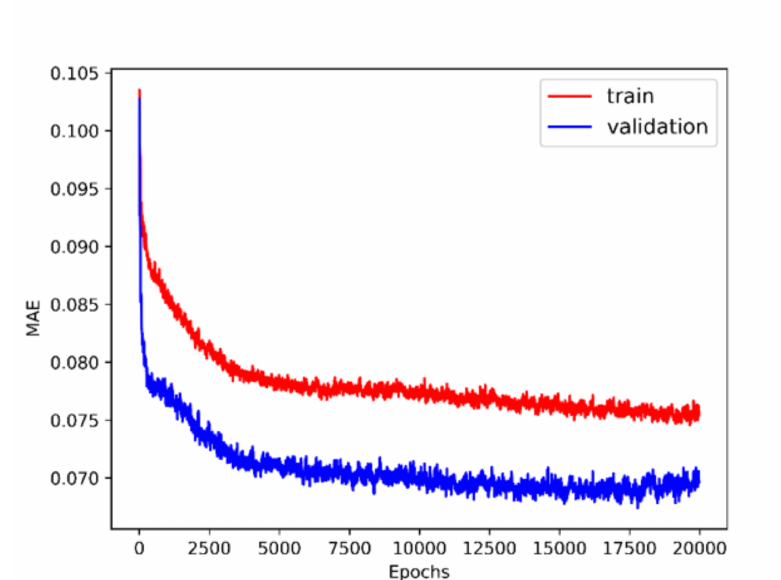
Figure 9. Five-fold cross validation results (synthetic